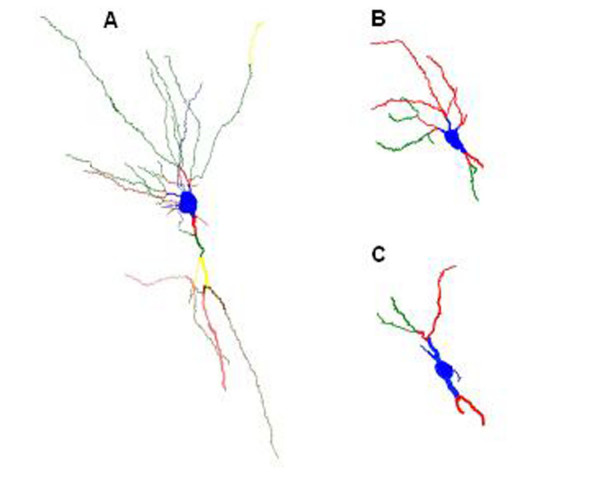
Dendritic degeneration of CA1 pyramidal neurons in mouse hippocampus. Neurolucida renderings of CA1 pyramidal neurons stained by Golgi method; blue is soma and first order dendrites, red is second order dendrites, green is third order dendrites, yellow is fourth order dendrites, brown is fifth order dendrites, and pink is sixth order dendrites. A. Typical pyramidal neuron 24 hr after ipsilateral ICV Saline injection. B and C. Pyramidal neurons following ipsilateral ICV LPS injection showing moderate (B) to severe (C) dendrite shortening and spine loss.